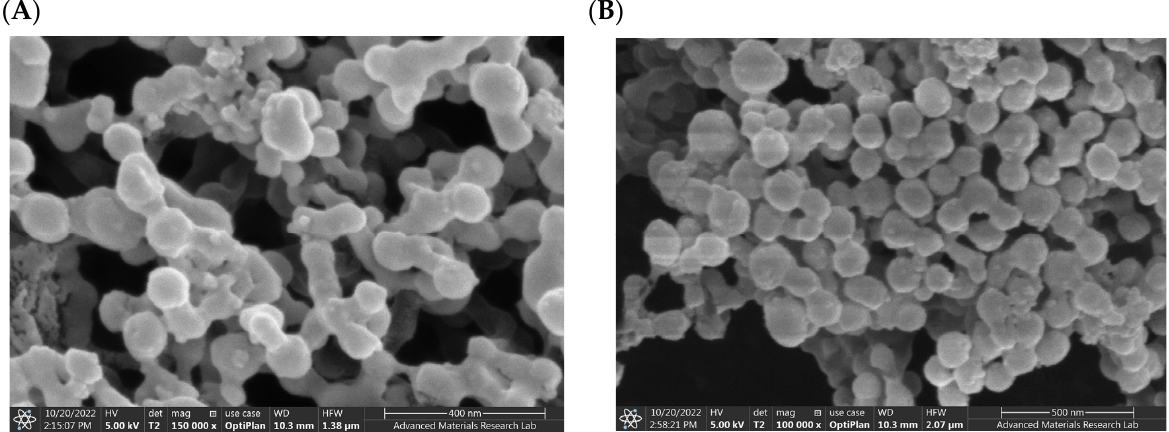
Figure 2. SEM images of synthesized PLGA NP: ( A ) SEM image of Irosustat (IRO) PLGA NP. ( B ) SEM image of STX140 (STX) PLGA NP.